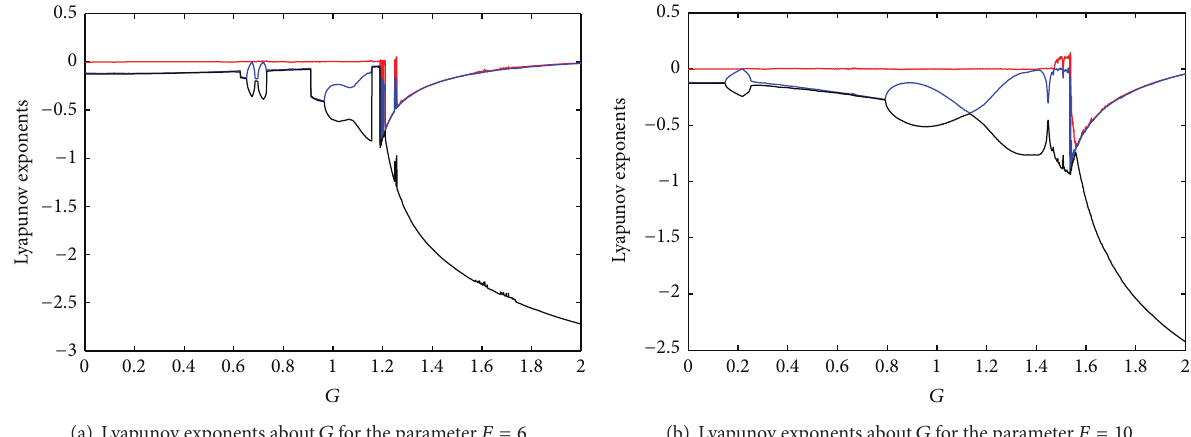
Figure 8: Lyapunov exponents about 𝐺 .